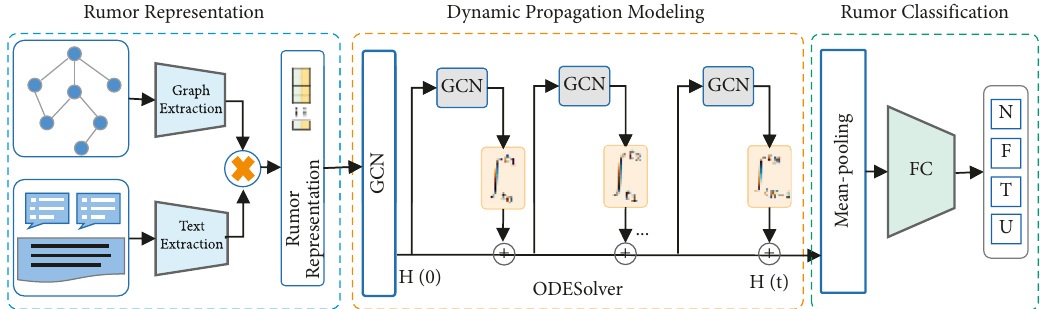
Figure 3: The workflow of the proposed model HDGCN. HDGCN consists of three steps: (1) obtaining rumor representation by joint content and rumor propagation structure graph, (2) modeling dynamic propagation by ODE-based GCN, and (3) predicting rumor